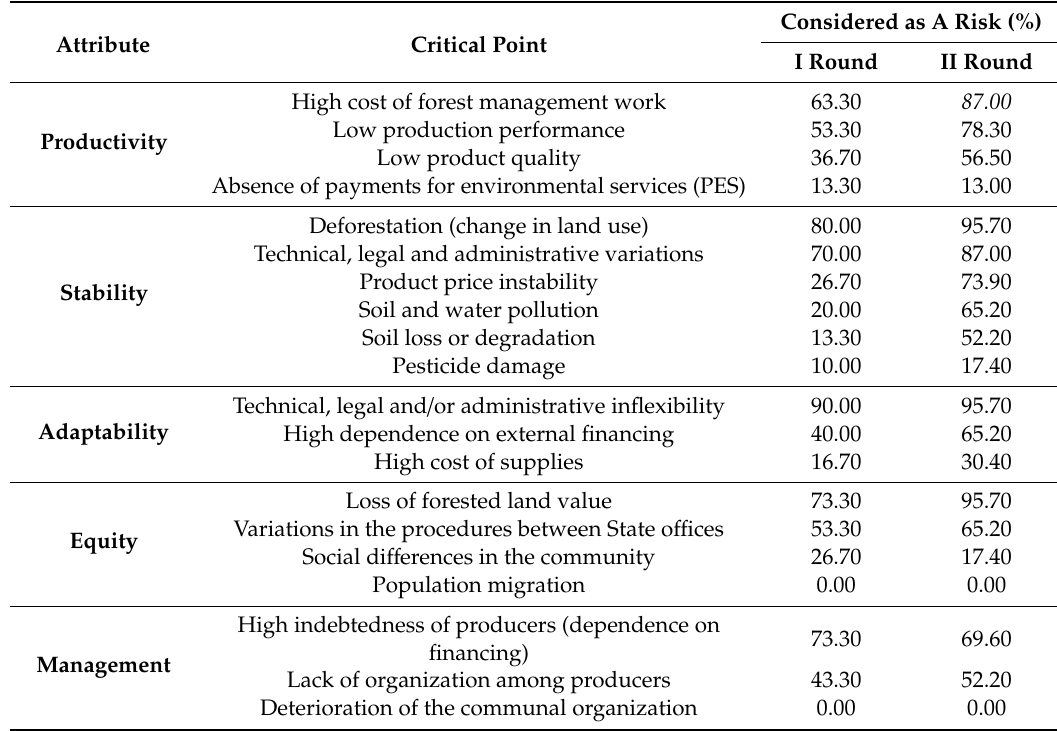
Table 2. Expert panel opinion on critical points of